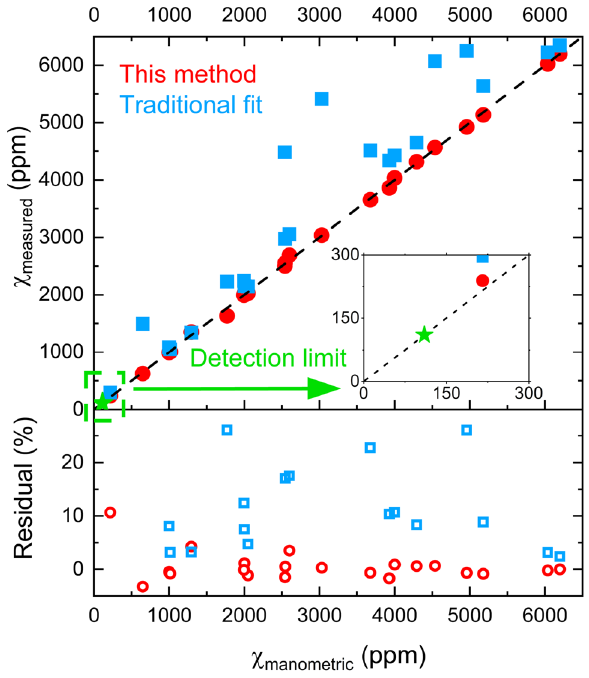
Figure 7. Comparison of measured and manometric methane mole fraction values. Minimum detection limit is 110 ppm at the experimental